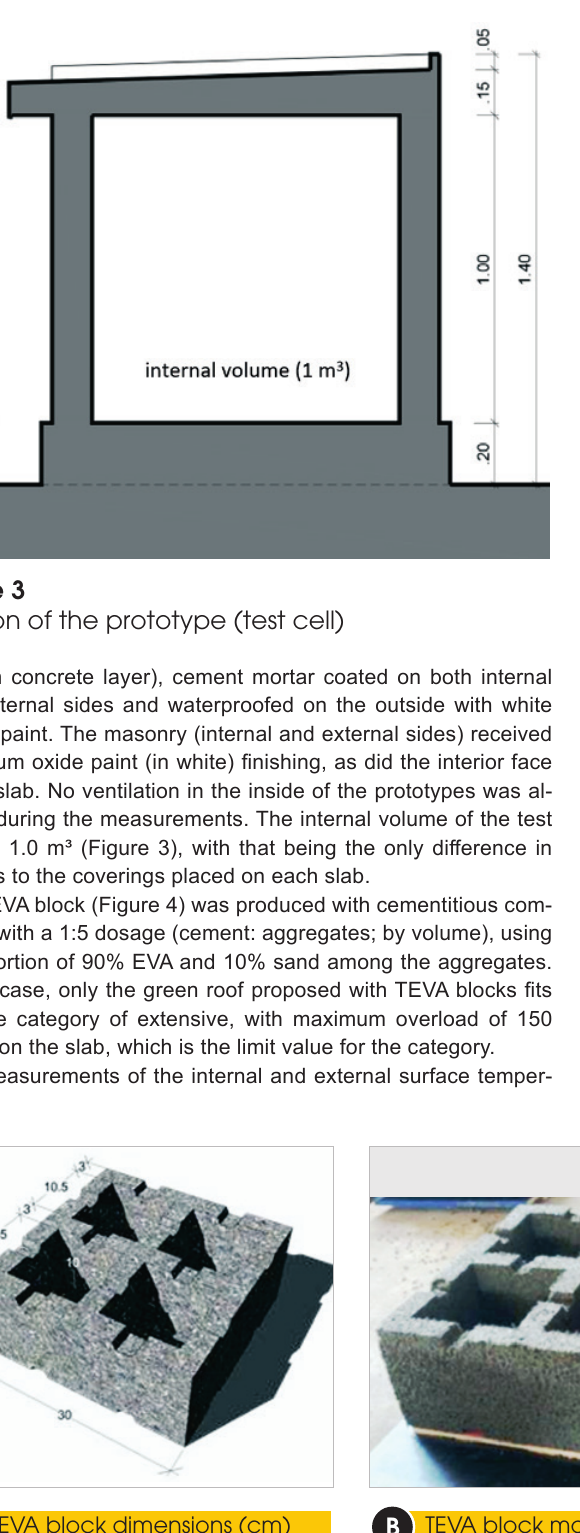
TEVA block dimensions (cm) TEVA block